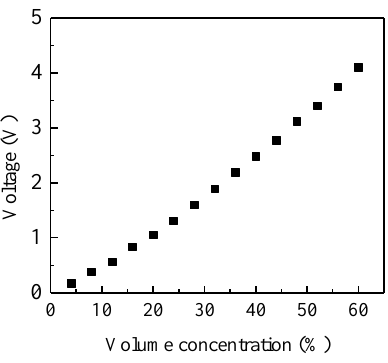
Figure 12. Average output voltage of the C/V circuit vs . concentration.